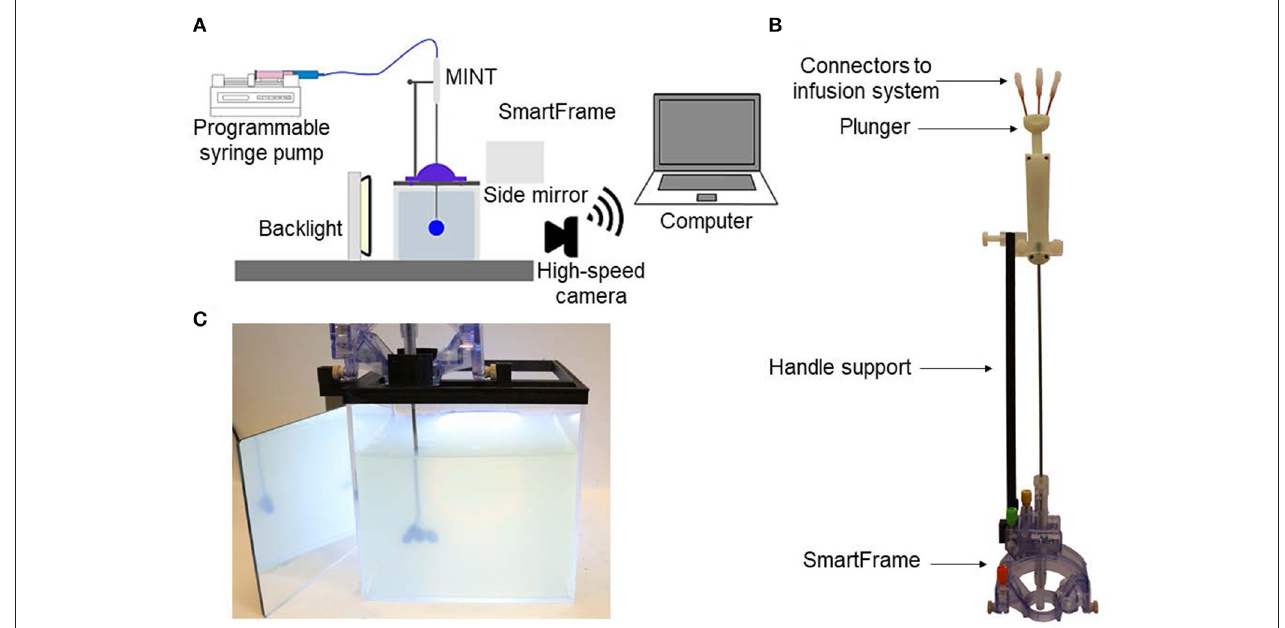
FIGURE 2 | (A) Schematics of the experimental setup for phantom CED tests. (B) Photograph of the MINT device inserted in the SmartFrame trajectory guidance stereotactic system (MRI Interventions Inc., Irvine CA), with the custom-designed side support. (C) Photograph of the MINT device inserted in the agarose brain phantom through the stereotactic frame at the end of the CED of 450 µ L of trypan blue